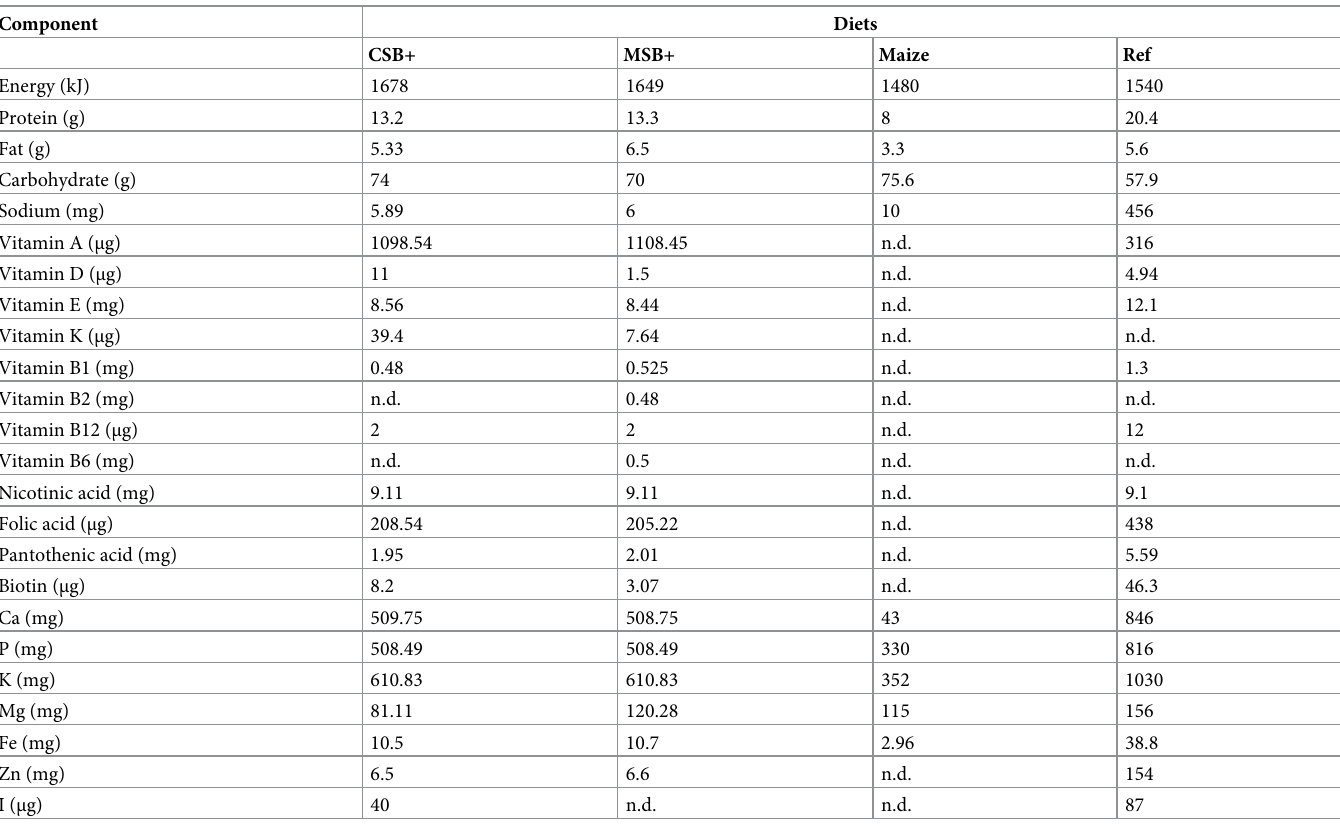
Per 100g edible portion. (n.d., not